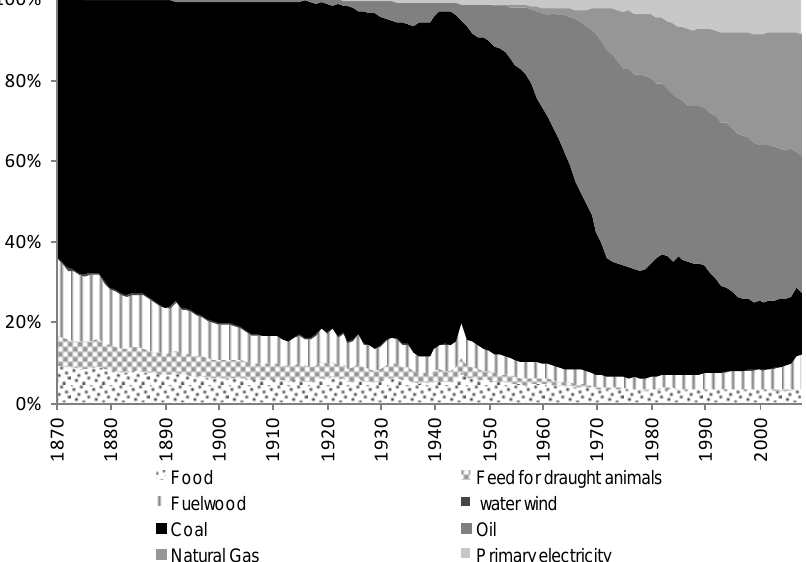
Figure 6. Shares of different energy carriers in primary energy inputs in Europe 1870–2009. Note: Primary electricity refers to electrical energy of geothermal, hydro, nuclear, tide, wind, wave/ocean and solar origin. Its production is assessed as the heat value of electricity [29]. As this figure displays primary energy inputs, only primary electricity is included used to avoid double-counting of fuels used for electricity production. Electricity produced from fuels such as coal or gas is considered to be kinetic energy in wind and water mills or sail